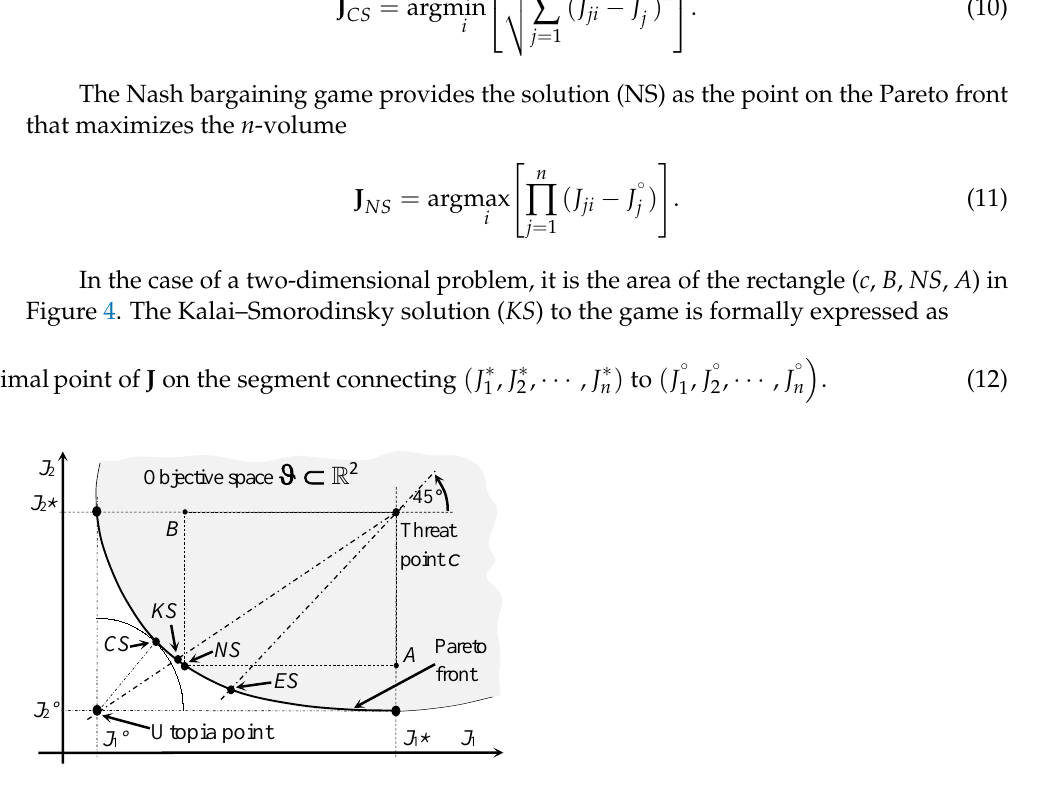
Figure 4. Description of a two-decisional decision maker according to bargaining games.